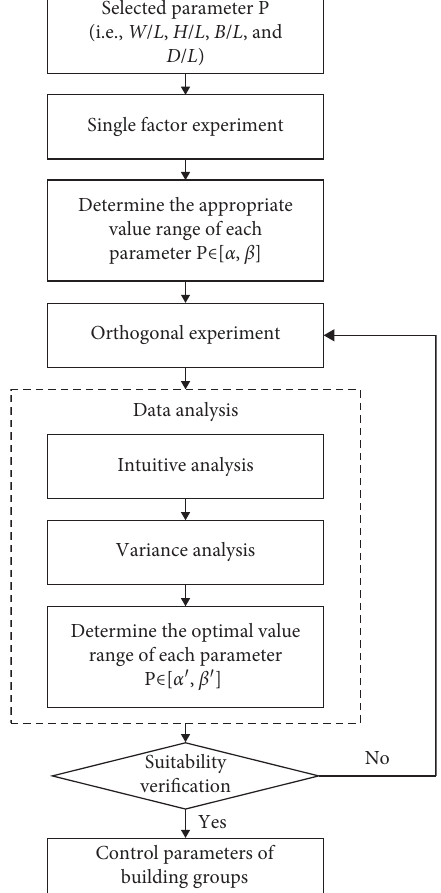
Figure 3: Technical roadmap of the entire experiment.